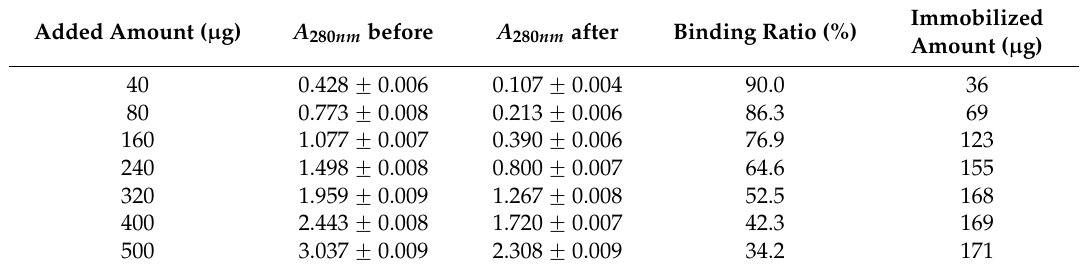
Table 2. Absorbance value of SPA solution before and after binding to gold-magnetic nanoparticles. Added Amount (µg)